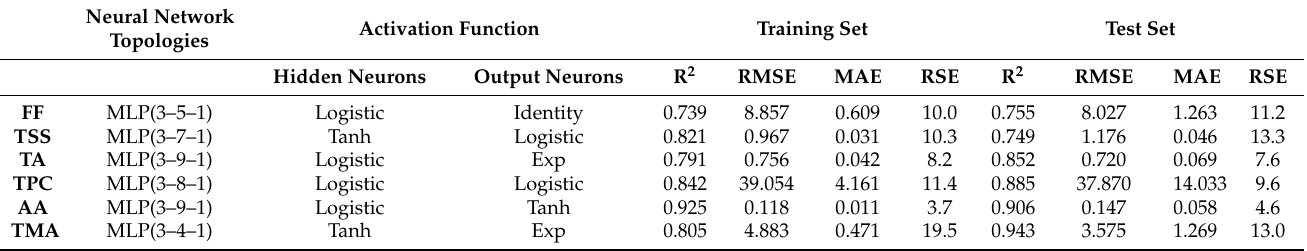
Table 4. Neural network architectures, regression metrics for highest training and test sets predictions, goodness of fit, and residual analysis for the developed ANN